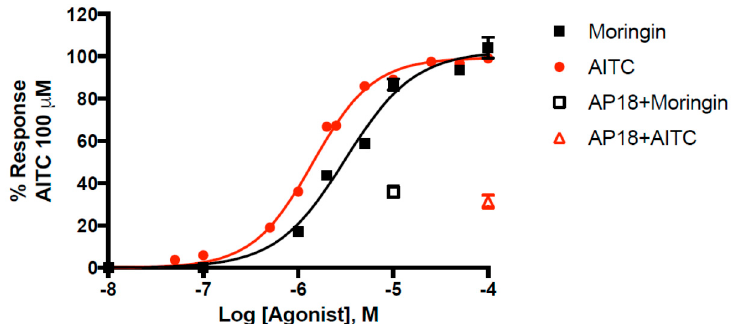
Figure 2. Dose-related effect of moringin and allylisothiocyanate (AITC) on elevation of intracellular Ca 2+ in human embryonic kidney (HEK)-293 cells stably transfected with rat TRPA1 (rTRPA1-HEK-293). AP18 = 4-(4-chlorophenyl)-3-methyl-3-buten-2-one oxime. Data are expressed as percentages of the effect observed with AITC 100 μ M.